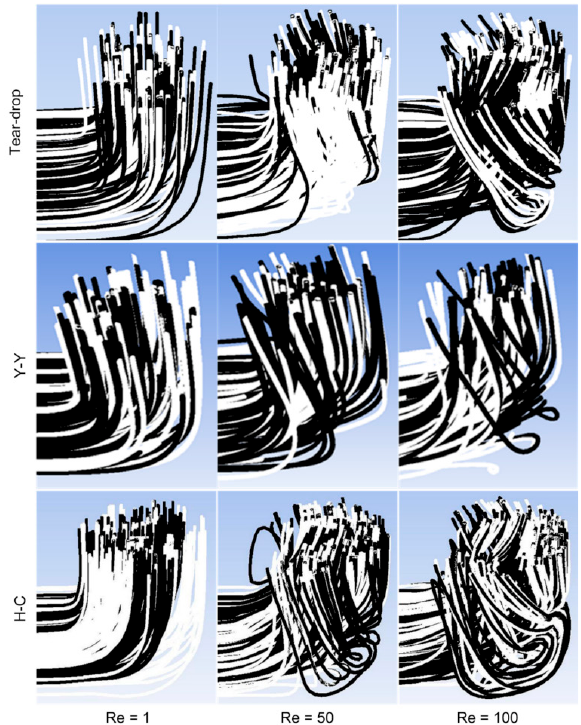
Figure 6. Path lines at the exit of the micromixers at different Reynolds numbers.